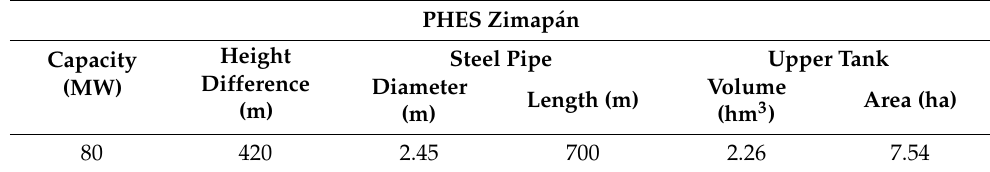
Table 1. Sizing of the PHES Zimapán.